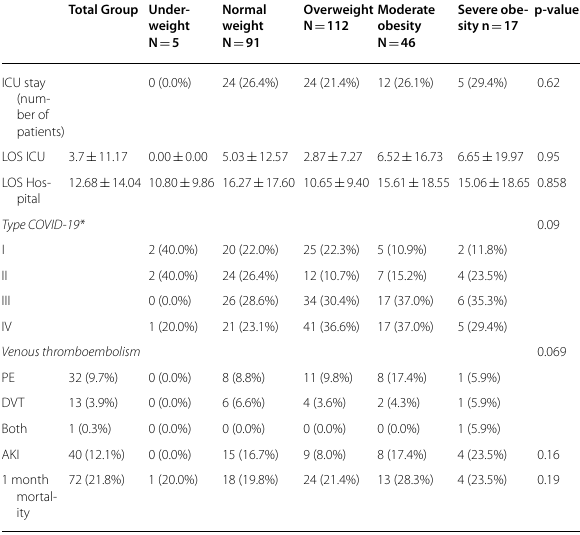
Table 1. A statistical significant association between BMI distribu- tion and disease severity or poor outcome was not detected in our cohort. Table 1. Overview of disease severity and outcomes, in total group and stratified for BMI distribution. Data are pre- sented as mean standard deviation or as numbers (frequencies). A ± p-value < 0.05 is considered statistically significant (Chi-square